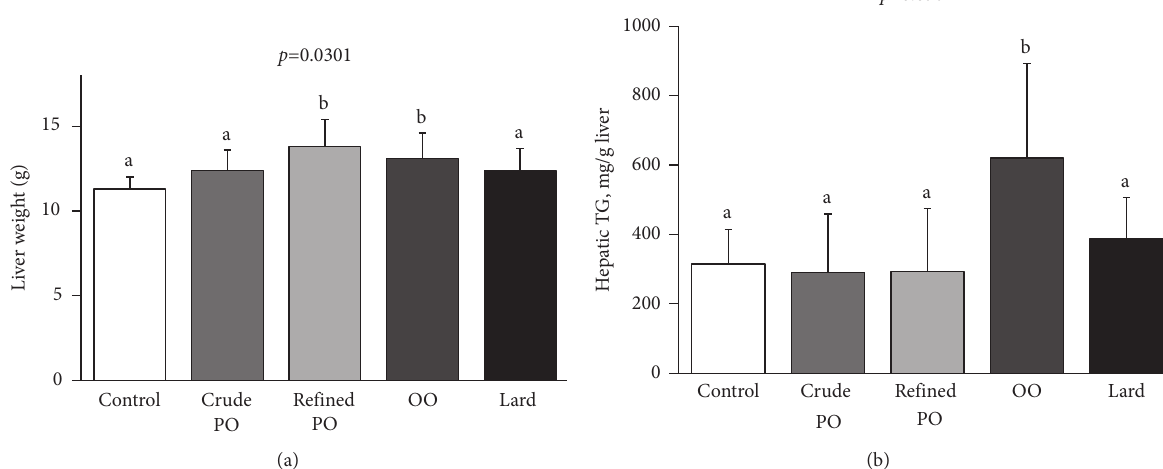
Figure 1: Effect of high dietary intake of palm oil, olive oil, and lard on (a) liver weight and (b) liver triglycerides. The results are expressed as mean values ± SD, n � 7-8 animals per group. The limit of statistical significance was set at p < 0 . 05. Bar graphs with different letters (a, b, and c) are significantly different. OO, olive oil; PO, palm oil; TG,